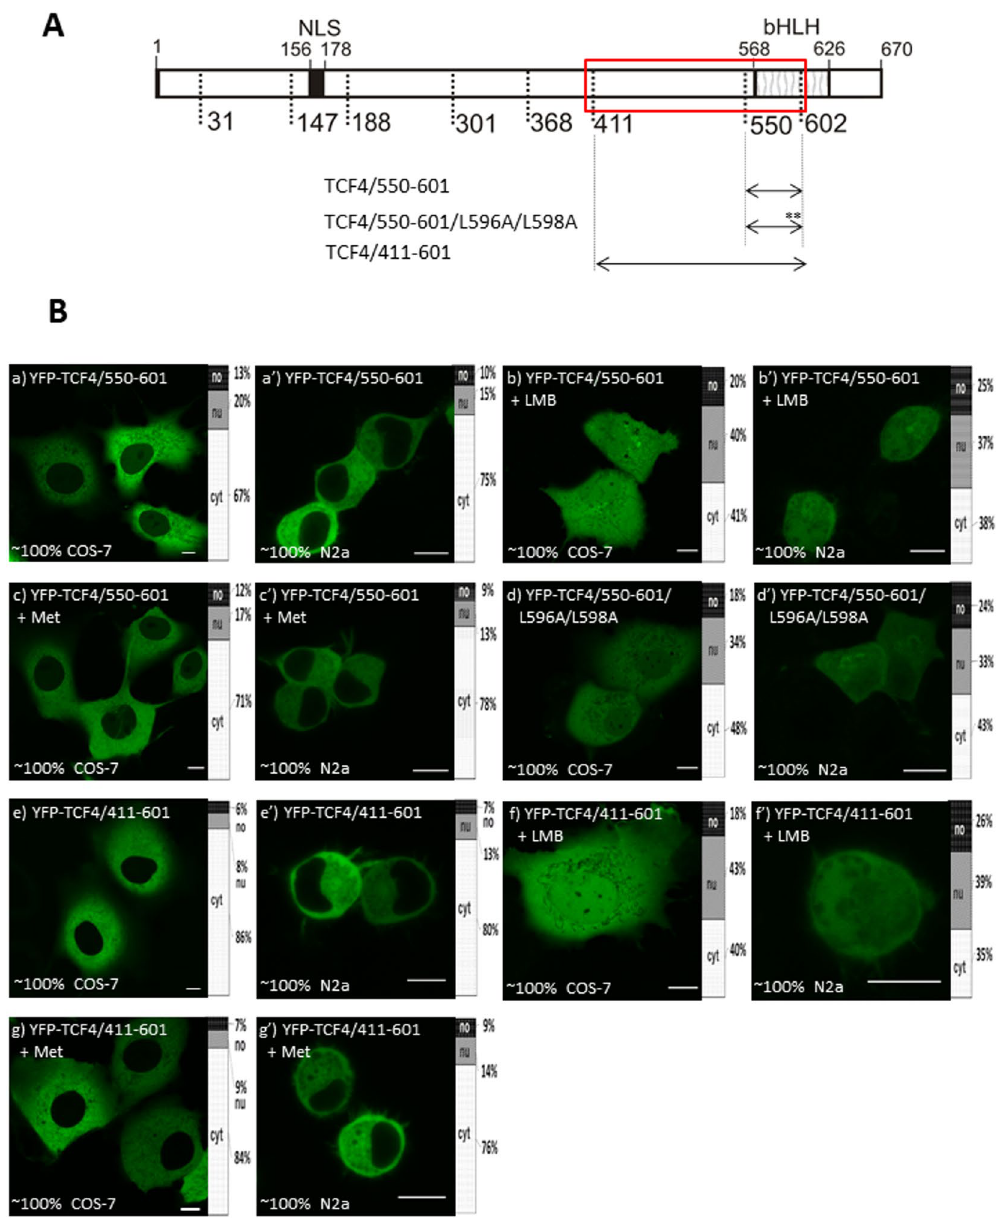
Figure 6. Subcellular distribution of deletion mutants (411-601aa) of TCF4 ( A ) Schematic representation of TCF4 protein. Region of the studied area of TCF4 is shown by the red rectangle. Expressed deletion mutants of TCF4 are depicted as arrows. Point mutations are depicted as stars. The length of each domain in the diagram is arbitrary. ( B ) Subcellular distribution of the deletion and point mutants of TCF4. Subcellular localizations of the expressed proteins were analysed by confocal microscopy 20-24 h after transfecting COS-7 and N2a cells in the absence or presence of additional factors such as LMB or methanol. Representative images (single confocal plane for confocal microscopy) of subcellular distribution of the derivatives of TCF4/411-601 area. Bar, 10 µ m. Ratios between mean fluorescence intensity in cytoplasmic, nuclear and nucleolar compartments are presented as an accumulated bar graph (no- nucleolus; nu- nucleus, cyt- cytoplasm). (a,a’) YFP-TCF4/550-601, (b,b’) YFP-TCF4/550-601 after LMB addition, (c,c’) YFP-TCF4/550-601 after methanol addition, (d,d’) YFP- TCF4/550-601/L596A/L598A, (e,e’) YFP-TCF4/411-601, (f,f’) YFP-TCF4/411-601 after LMB addition, (g,g’) YFP-TCF4/411-601 after methanol